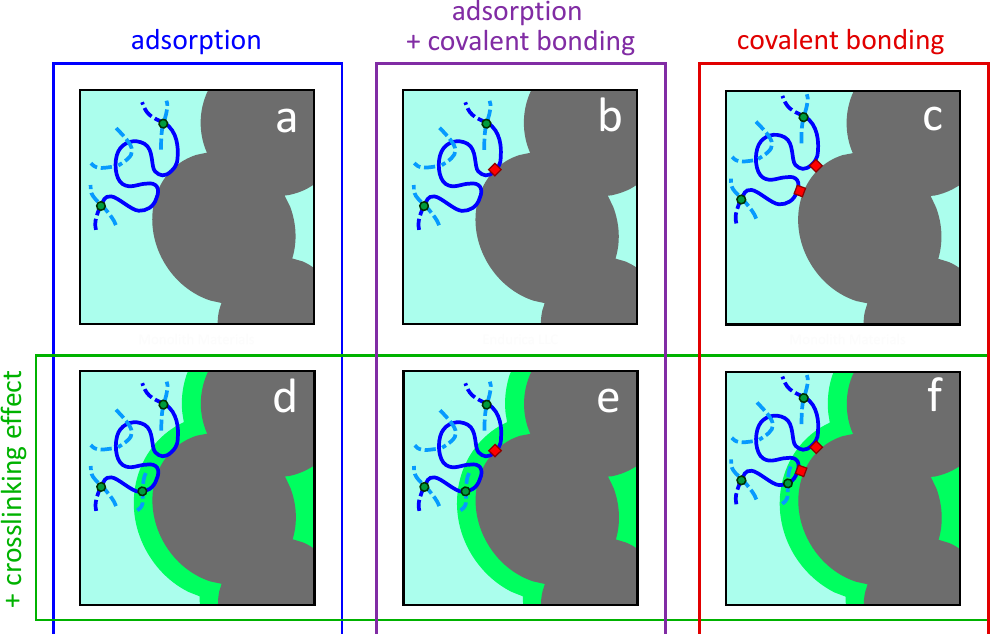
Figure 16. Possible polymer–filler interaction/reaction scenarios for crosslinked elastomer reinforced with nano-structured filler aggregates. A portion of filler aggregate is illustrated (gray) with one full primary particle shown that is fused to two other primary particles. The solid blue line represents a polymer network chain between crosslinks (green dots). Covalent polymer–filler bonds are indicated with red squares. The green halo surrounding the filler aggregate in ( d – f ) signifies a region of increased crosslink density due to proximity to filler, with an additional crosslink (green dot) therein compared to ( a – c ). A discussion of relative sizes of polymer network chains and primary particle diameters for CB-filled rubber is given elsewhere [122].